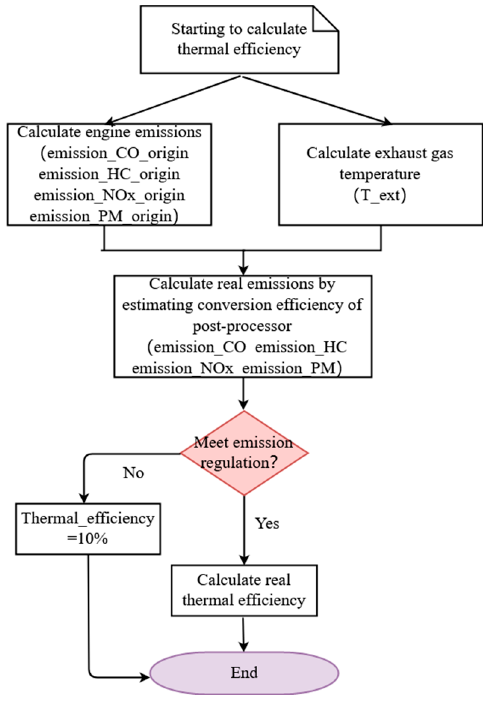
Figure 9. Framework of virtual thermal efficiency calculation. Table 4. The variation range of combustion control parameters.